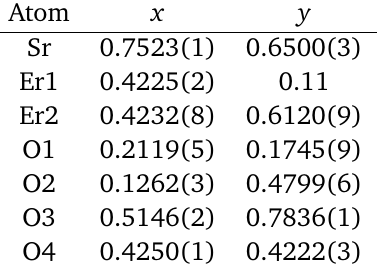
O obtained from neutron diffraction 2 4